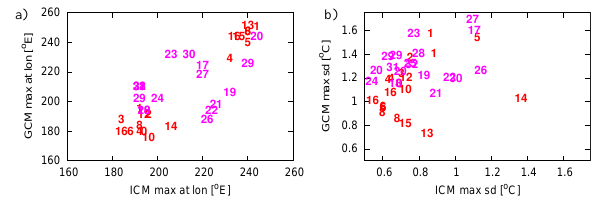
Fig.9. (a) LocationofmaximumSSTstandarddeviationindegrees Fig. 9. (a) Location of maximum SST standard deviation in degrees E.IftwolocationsexistinbothGCMandICMrun,bothareplotted. (b) Amplitude at the location of maximum SST standard deviation E. If two locations exist in both GCM and ICM run, both are plotted. ofGCMensemblemembersvscorrespondingICMruns. Inredthe (b) Amplitude at the location of maximum SST standard deviation ATM-full-runs and in pink the OCN-full-runs. of GCM ensemble members vs. corresponding ICM runs. In red the ATM-full-runs and in pink the